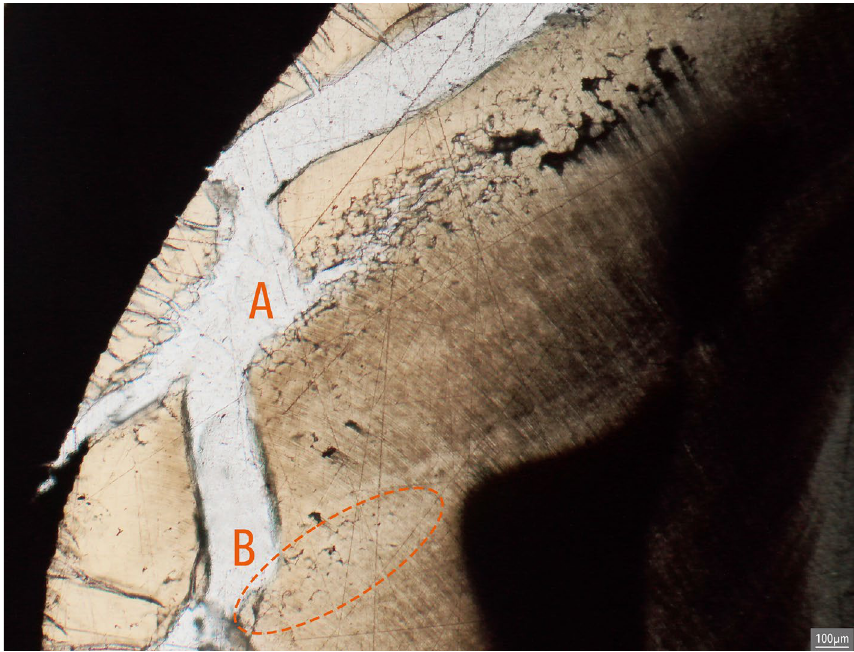
Figure 3. Two bands of IGD in the permanent left 1st mandibular molar from B121 after burning at 800 °C for 2 h. Band A has Grade 3 and shows both partially fused calcospherites (close to the A) as well as the dark semi-circular spaces towards the end of the band. Band B (see orange oval) has Grade 1. Note the heat-induced damage (white cracks) to the dentine (light brown).